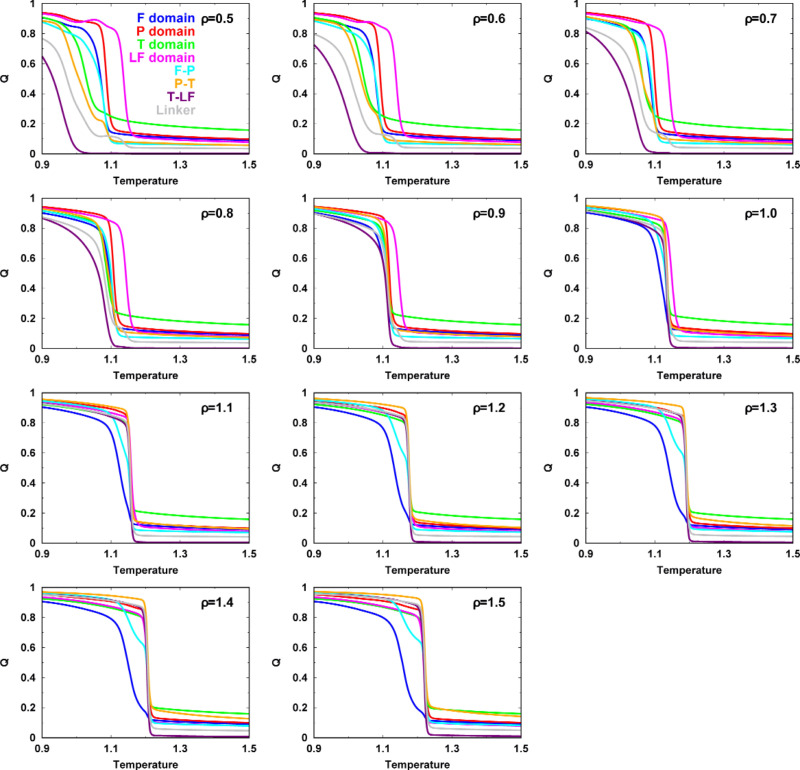
Melting curves of Q for each intra-, interdomain of DPO4 for different values of ρ.